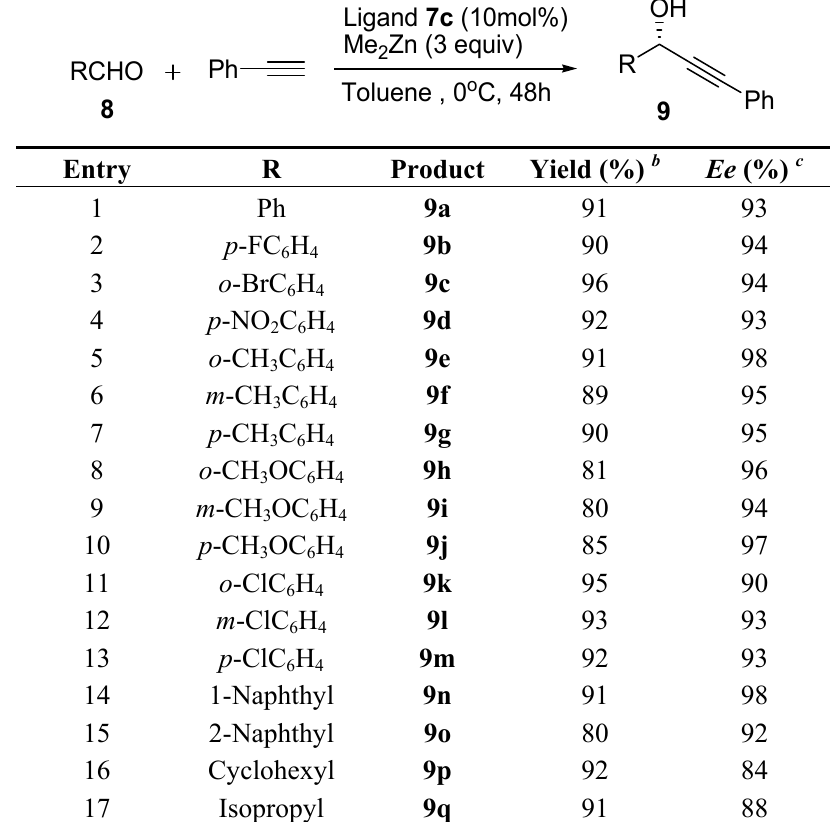
Table 3. Substrate scope for the addition of phenylethynylzinc to aldehydes a .